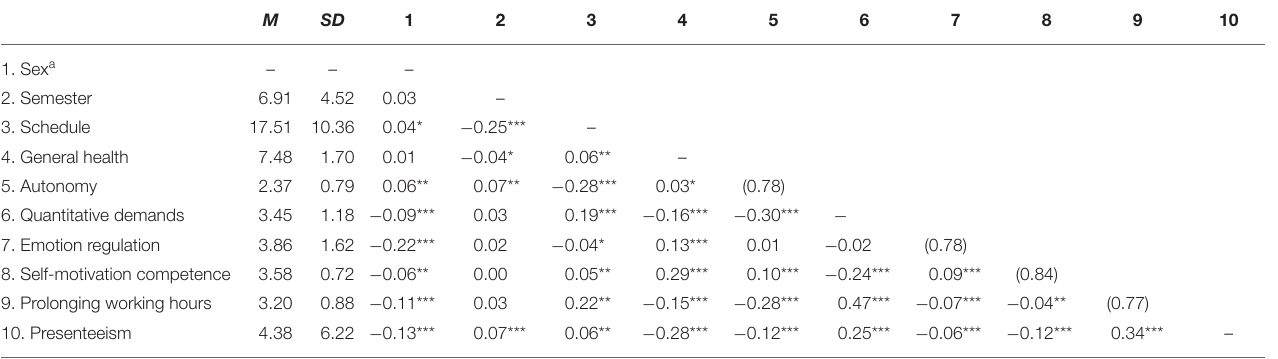
TABLE 1 | Bivariate correlations, means, and standard deviations of study variables.